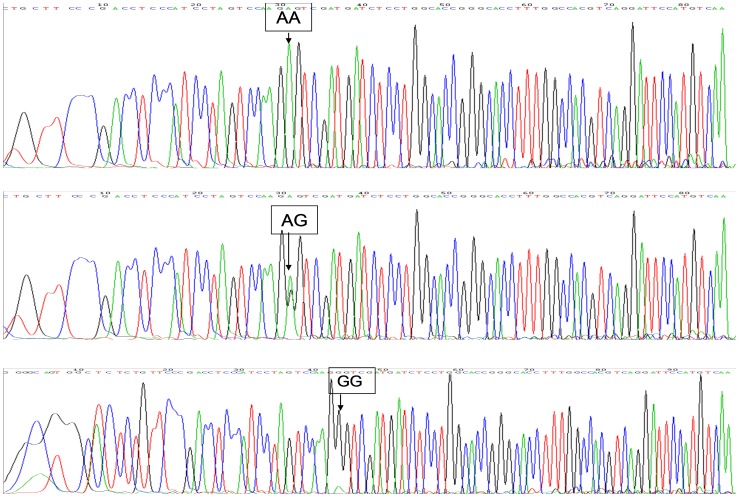
Genotyping results of the gene of VKORC1.
AA represents the AA genotype of VKORC1 gene. AG represents the AG genotype of VKORC1 gene. GG represents the GG genotype of VKORC1 gene.